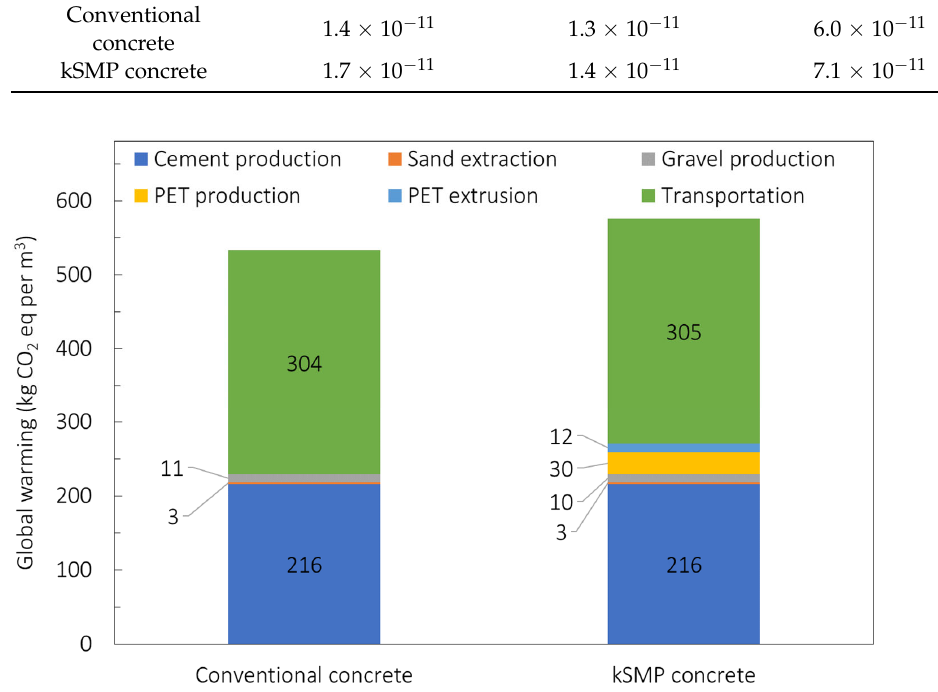
Figure 12. Comparison of normalised values of global warming potential for conventional concrete and kSMP concrete.